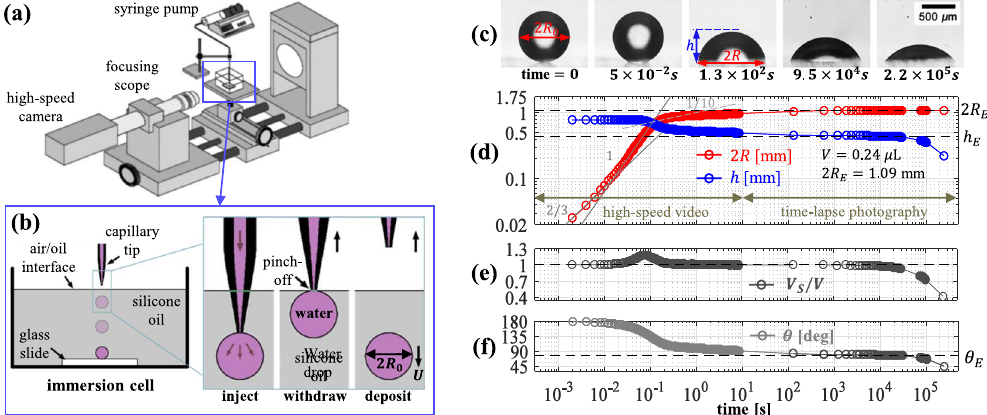
Figure 1. Experimental procedure and analysis. ( a ) Experimental apparatus to study spreading of water droplets in 100-cSt silicone (PDMS) oil. ( b ) Sequence of steps leading to the gentle deposition of a water droplet on a borosilicate slide. ( c , d ) Observed time evolution of contact radius R and height h obtained from digital images recorded at 32 fps during 10 s ( R 0 = 0.4 mm, V = 0.27 μ L). Power-law fits are included for comparison. ( e , f ) Volume V S = π h ( R 2 /2 + h 2 /6) and contact angle θ corresponding to a spherical